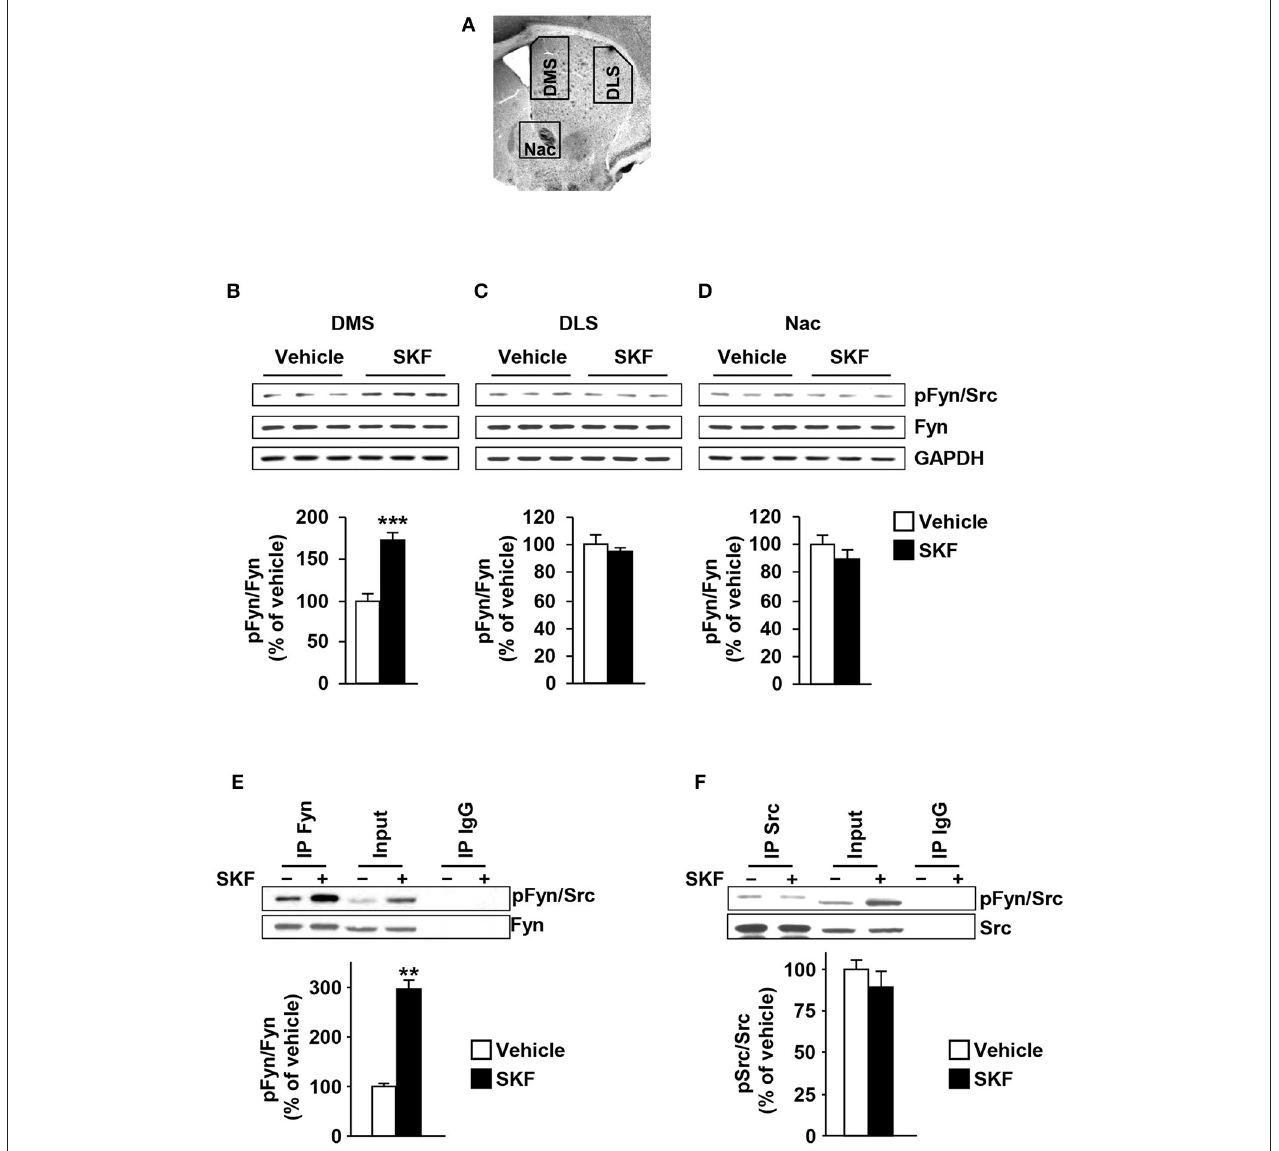
FIGURE 1 | Dopamine D1R stimulation activates Fyn but not Src in the DMS but not in the DLS or NAc. (A) Schematic representation of DMS, DLS, and NAc dissection. (B–D) SKF81297 (SKF, 5 mg/kg) or vehicle (2% DMSO) was systemically administered (i.p.). The DMS (B) , DLS (C) , and NAc (D) were collected 15 min after drug administration. The level of Tyr420 phosphorylation (pFyn) (upper panel), Fyn (middle panel), and GAPDH, which was used as a loading control (bottom panel) were determined by western blot analysis. Data are presented as the densitometry value of the pFyn divided by the densitometry values of Fyn ± SEM and expressed as % of vehicle. (E,F) Mouse striatal sections were treated with SKF81297 (SKF, 10 µ M) or vehicle (0.1% DMSO) for 15 min. The DMS was dissected and Fyn or Src were immunoprecipitated using anti-Fyn (IP Fyn) (E) or anti-Src (IP Src) (F) antibodies. Mouse IgG was used as a negative control (IP IgG). Fyn and Src immunoreactivity (lower panels) as well as Tyr417/420[Src/Fyn] phosphorylation (upper panels) were determined by westernblot analysis. Protein levels in the total lysates were measured in parallel (Input). Two-tailed t -test. (B–D) *** p < 0.001, n = 6 mice per treatment. (E,F) ** p < 0.01, n = 3 mice per treatment.